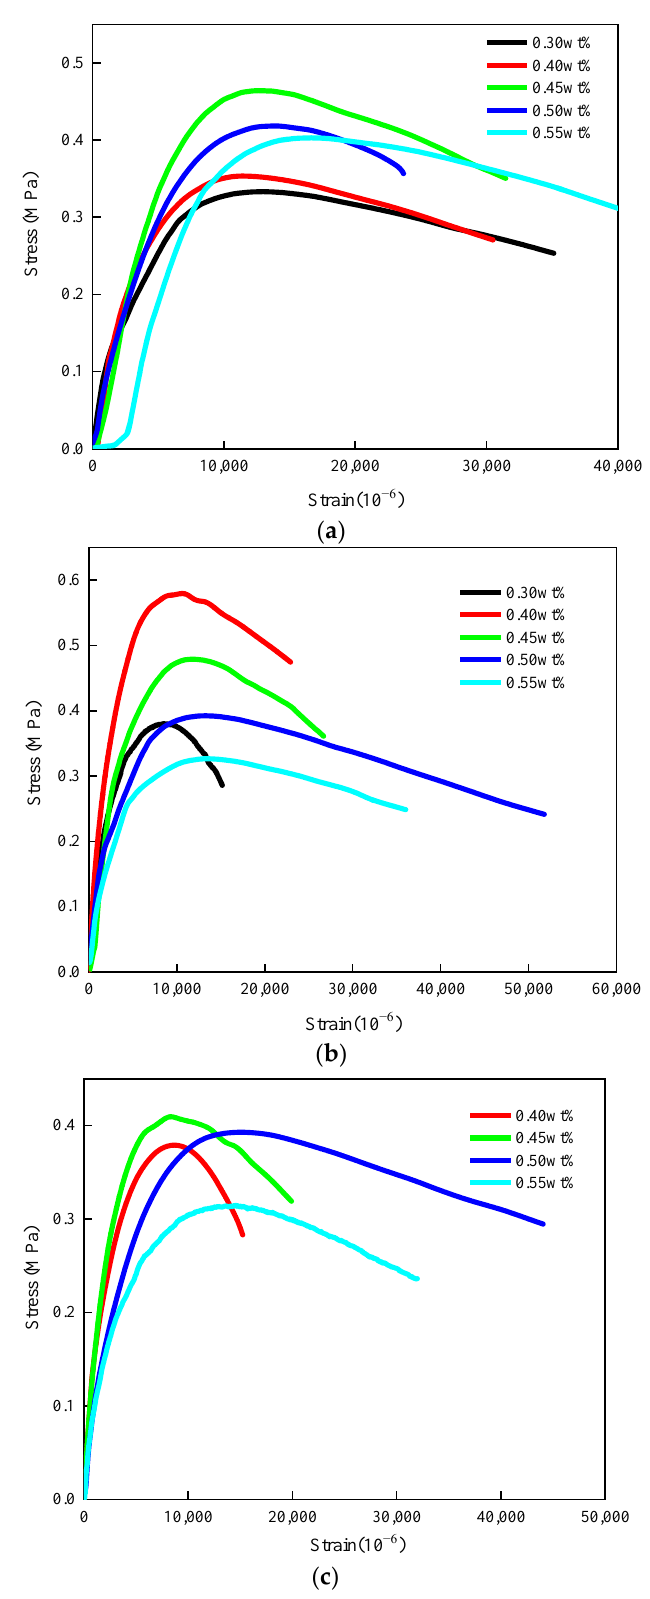
Figure 2. Stress – strain curves: ( a ) GFSMA; ( b ) FFSMA; ( c ) BFSMA. Figure 2. Stress–strain curves: ( a ) GFSMA; ( b ) FFSMA; ( c )